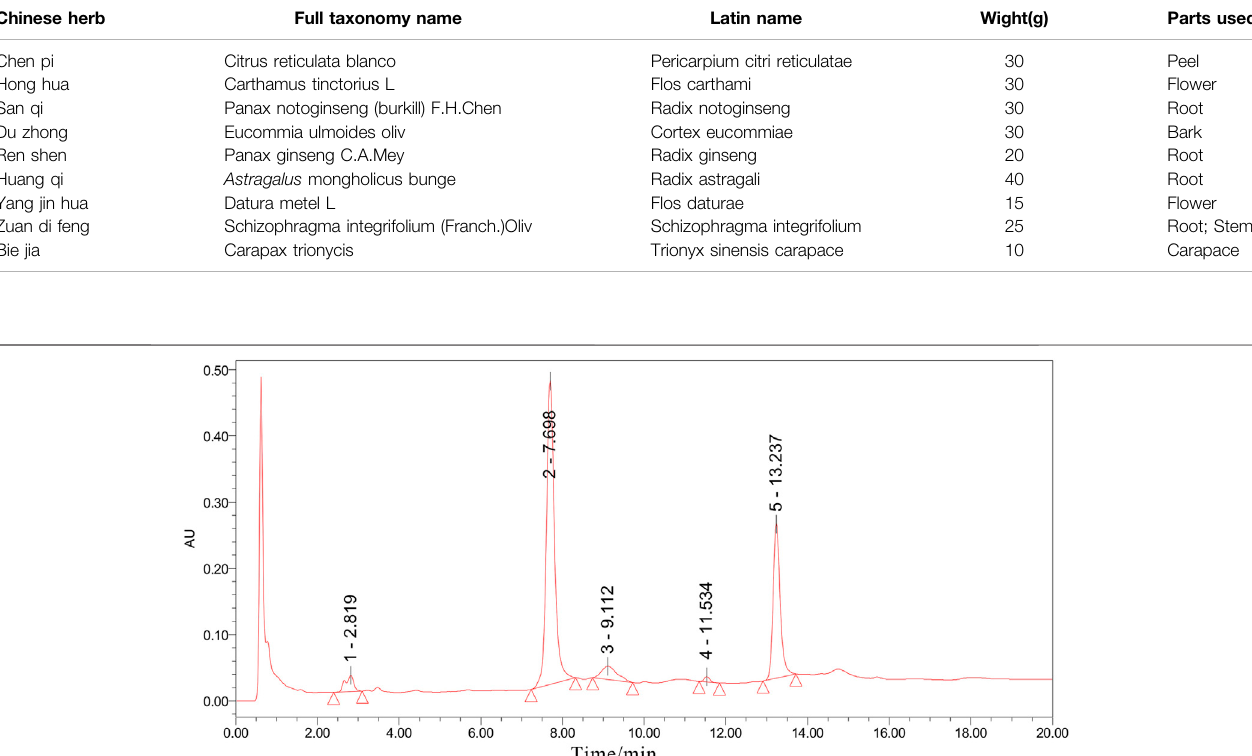
Frontiers in Pharmacology |